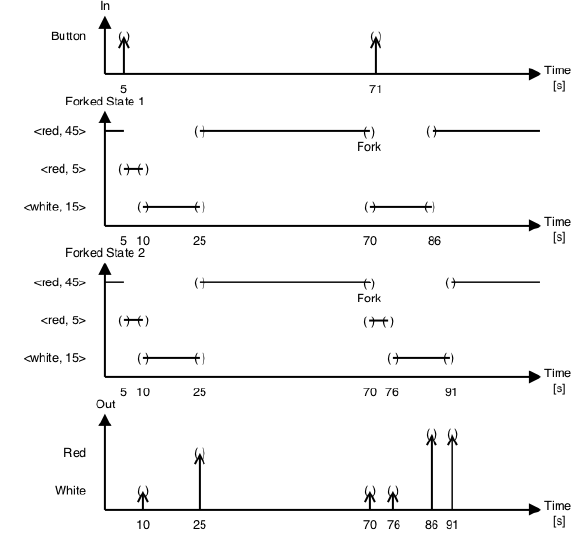
Figure 3: Trajectories of traffic light with input of 1 second